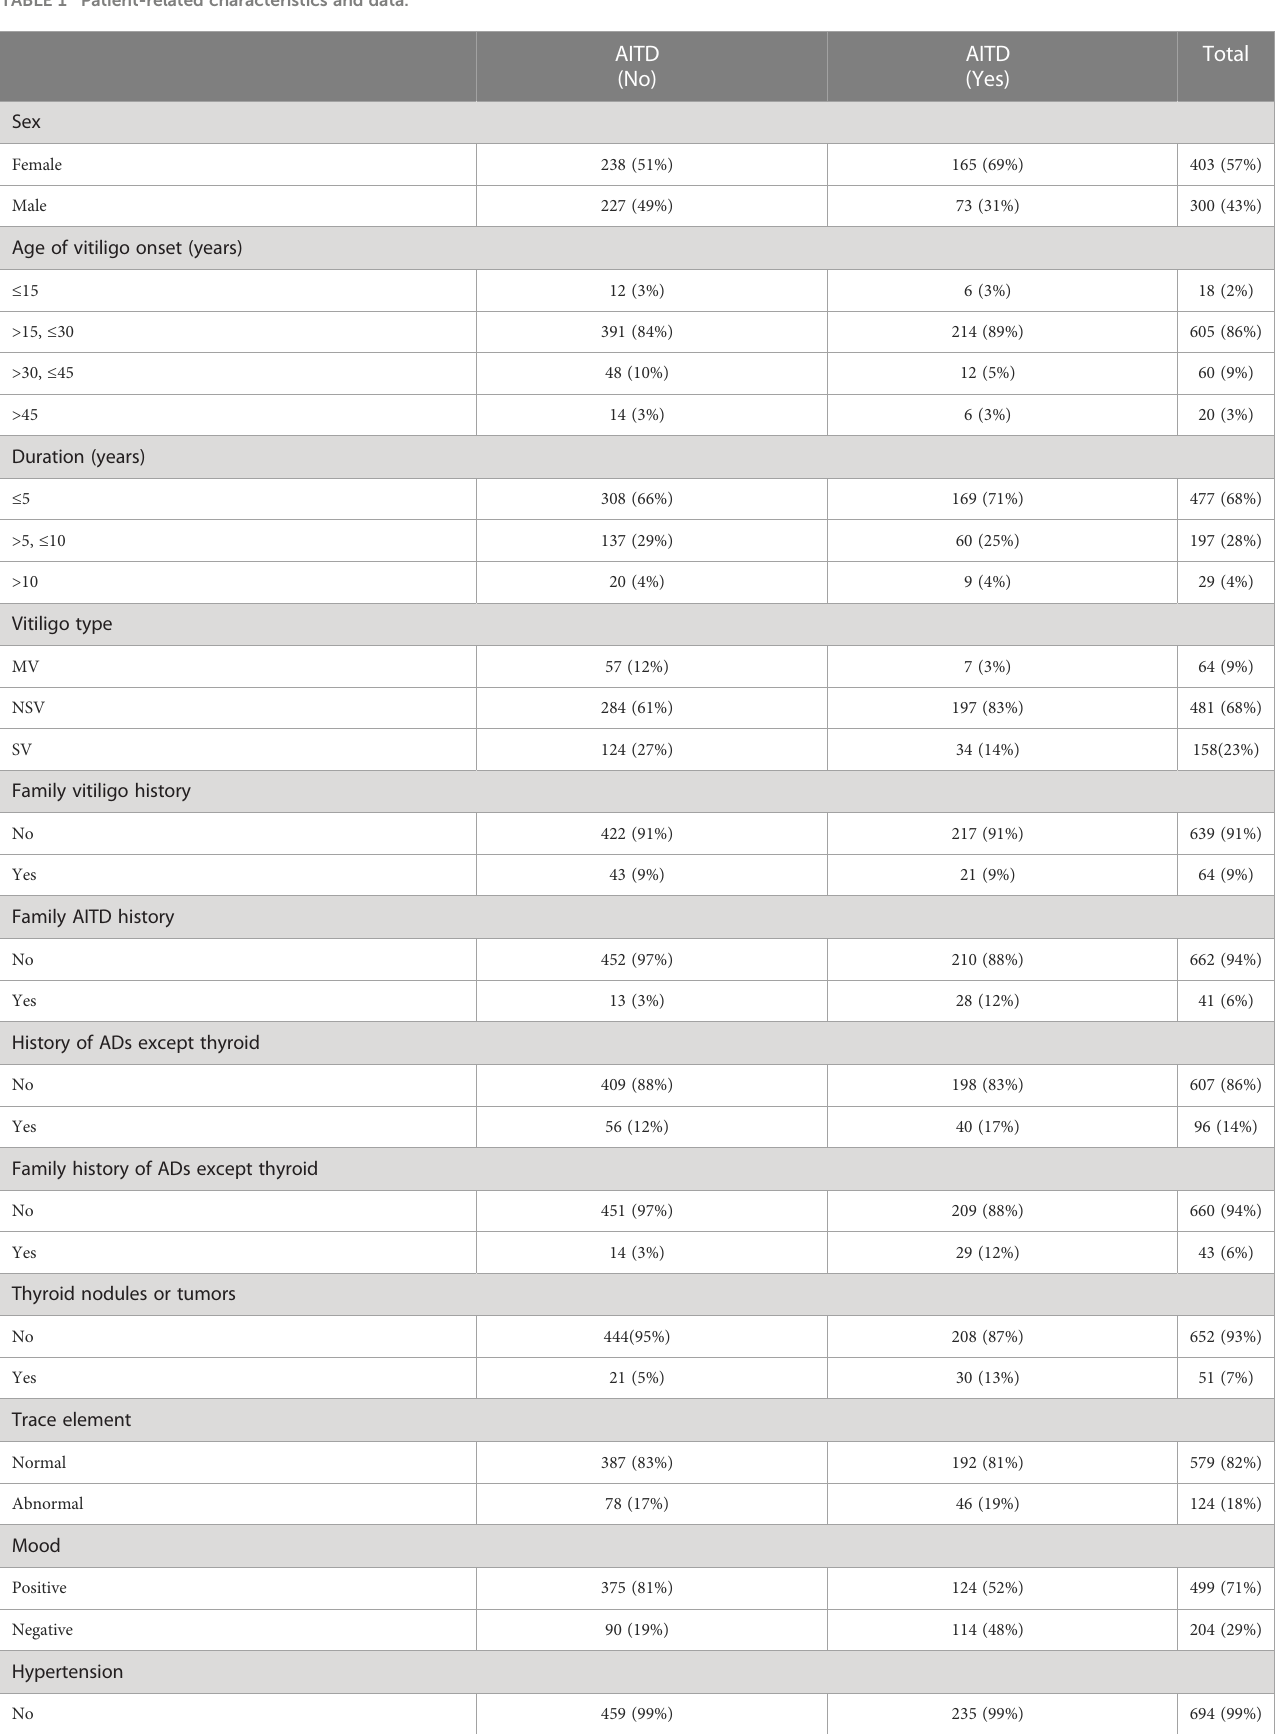
TABLE 1 Patient-related characteristics and